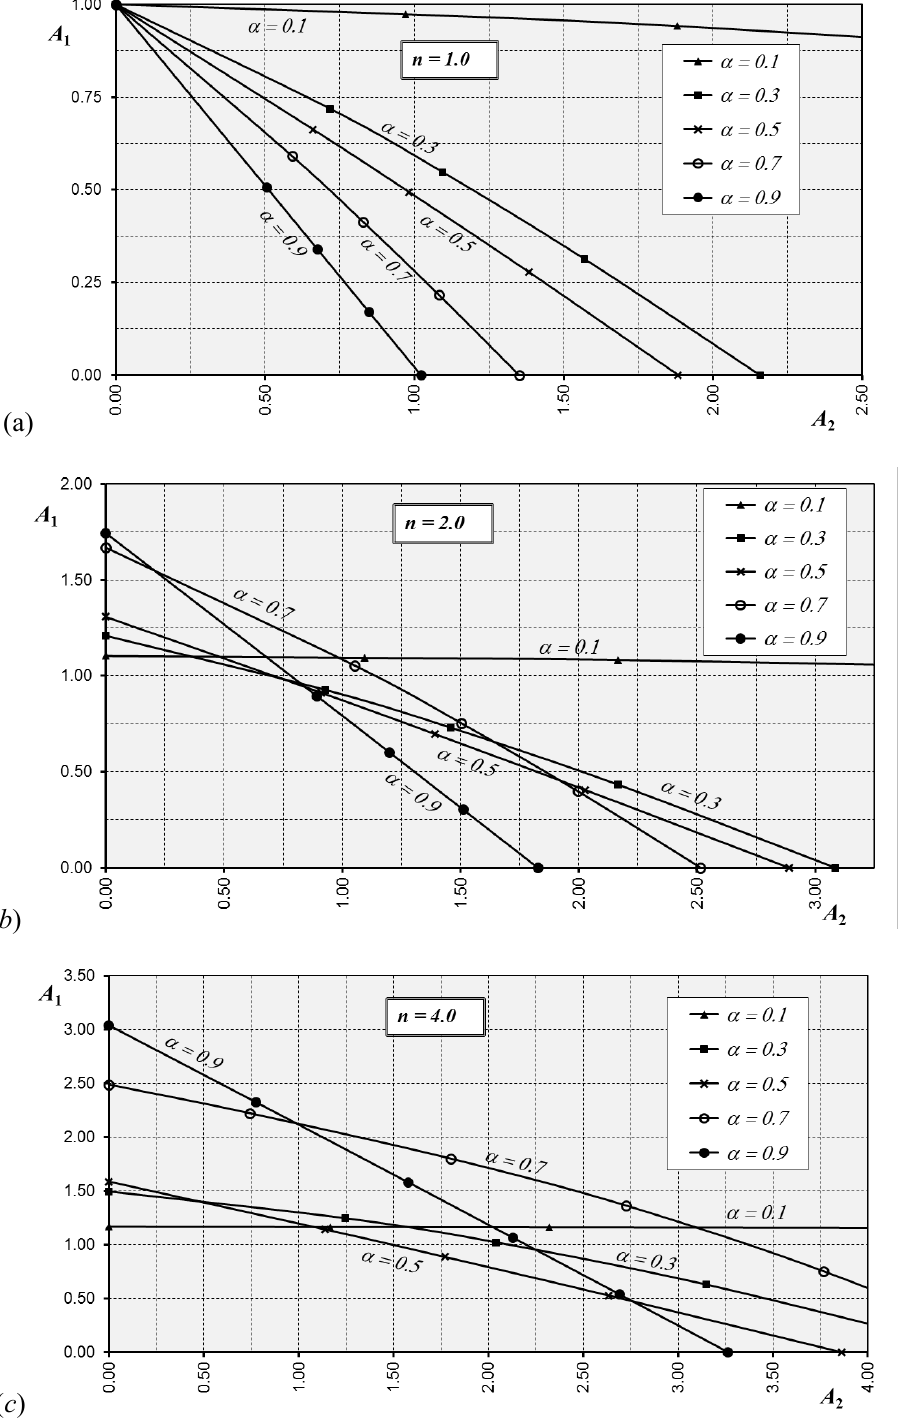
Fig. 5. Bucking loads parameters of columns with clamped ends (C-C) under intermediate load P and end load P 2 1 (a) n=1.0, (b) n=2.0 and (c)